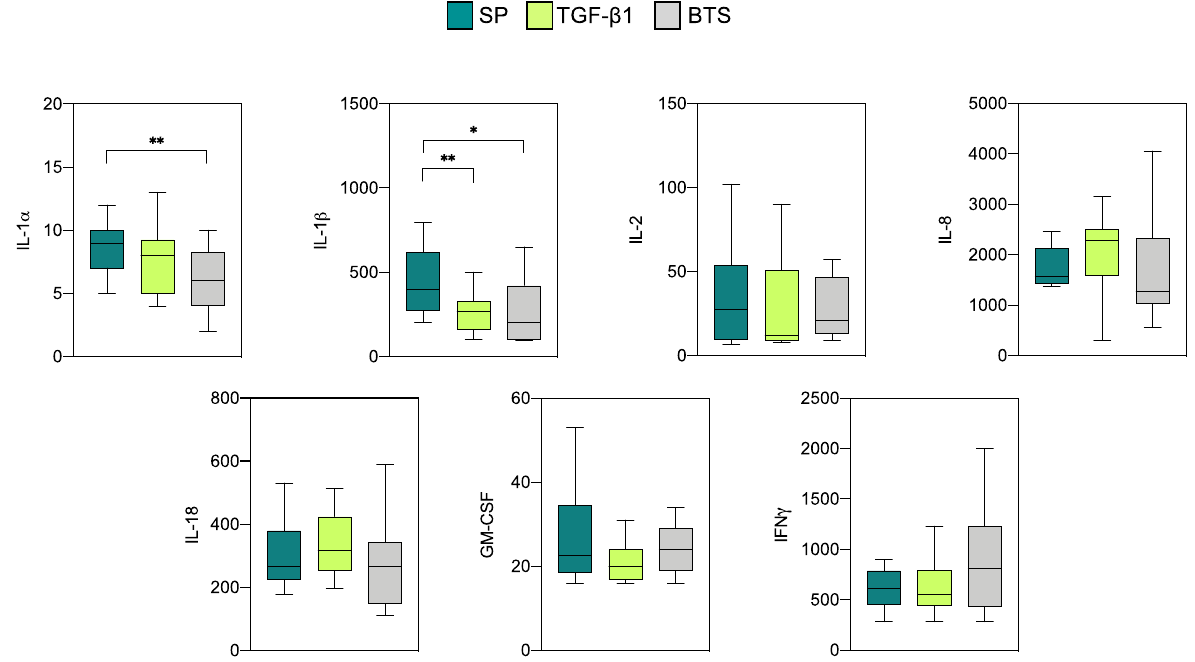
Figure 4. Levels of proinflammatory cytokines (pg/mL) on day 6 of the cycle in endometrial explants of “recipient” sows infused with 40 mL of SP, TGF- β 1 in BTS extender (TGF- β 1), or extender alone (BTS) 30 min prior to insemination. These sows were not inseminated. The box plots show the median (line) and the interquartile ranges (boxes, Q1 – Q3). * p < 0.05, ** p < 0.01.